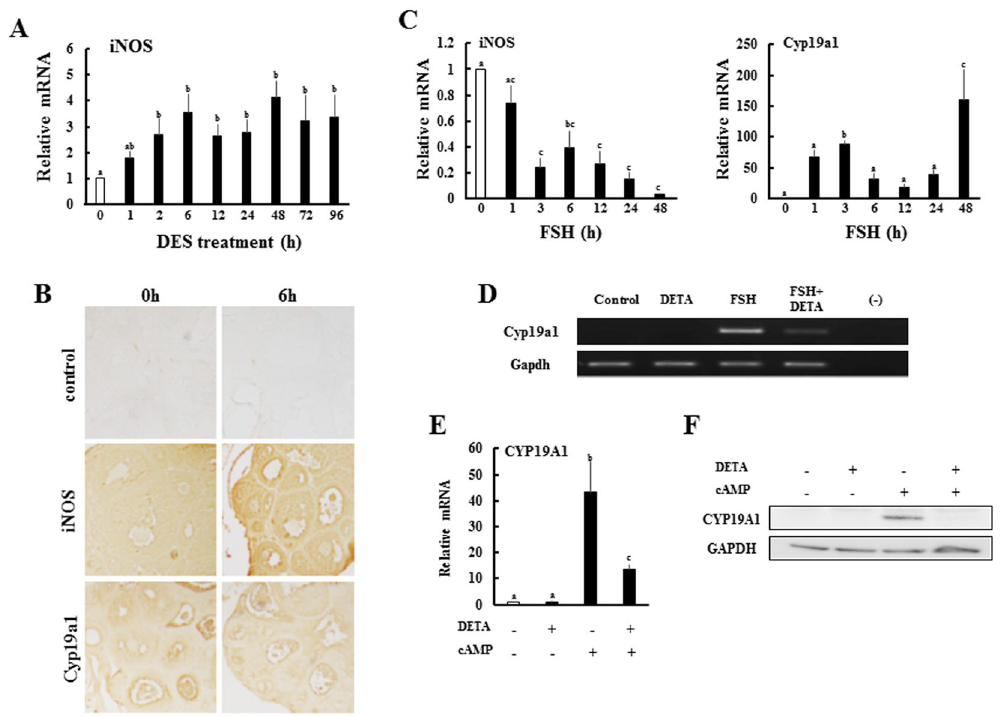
Figure 7. Effects of nitric oxide (NO) on Cyp19a1 expression in granulosa cells. ( A ) Expression of ovarian inducible nitric oxide synthase (iNOS) gene in DES-treated animals for the indicated times. Q-PCR data represent the mean ± SEM of at least four independent samples. Values marked by different letters are significantly different (P < 0.05). ( B ) Localization of iNOS and Cyp19a1 proteins in immature ovaries before (0 h) or after (6 h) DES injection. Both proteins were localized on granulosa cells. No staining was observed in control sections incubated with nonimmune serum. ( C ) Granulosa cells were isolated from immature DES-primed rats and treated with FSH (30 ng/ml) for the indicated times. Gene expression of each gene was measured by Q-PCR. Q-PCR data represent the mean ± SEM of at least four independent samples. Values marked by different letters are significantly different ( P < 0.05). ( D ) Granulosa cells were isolated from immature DES-primed rats and treated with FSH (30 ng/ml) and DETA NONOate (50 μ M) for 4 h. Gene expression of each gene was measured by RT-PCR. Uncropped images are shown in Supplementary Fig. S3. Effects of NO generator on expression of CYP19A1 mRNA ( E ) and proteins ( F ) in KGN cells. KGN cells were treated with 8-br-cAMP (1 mM) and DETA NONOate (50 μ M) for 24 h. ( E ) CYP19A1 gene expression was measured by Q-PCR. Q-PCR data represent the mean ± SEM of at least four independent samples. Values marked by different letters are significantly different ( P < 0.05). ( F ) Western blot analyses were performed with antibodies against CYP19A1 and GAPDH using lysates from KGN cells (30 μ g protein) in each group. Uncropped blots are shown in Supplementary Fig.